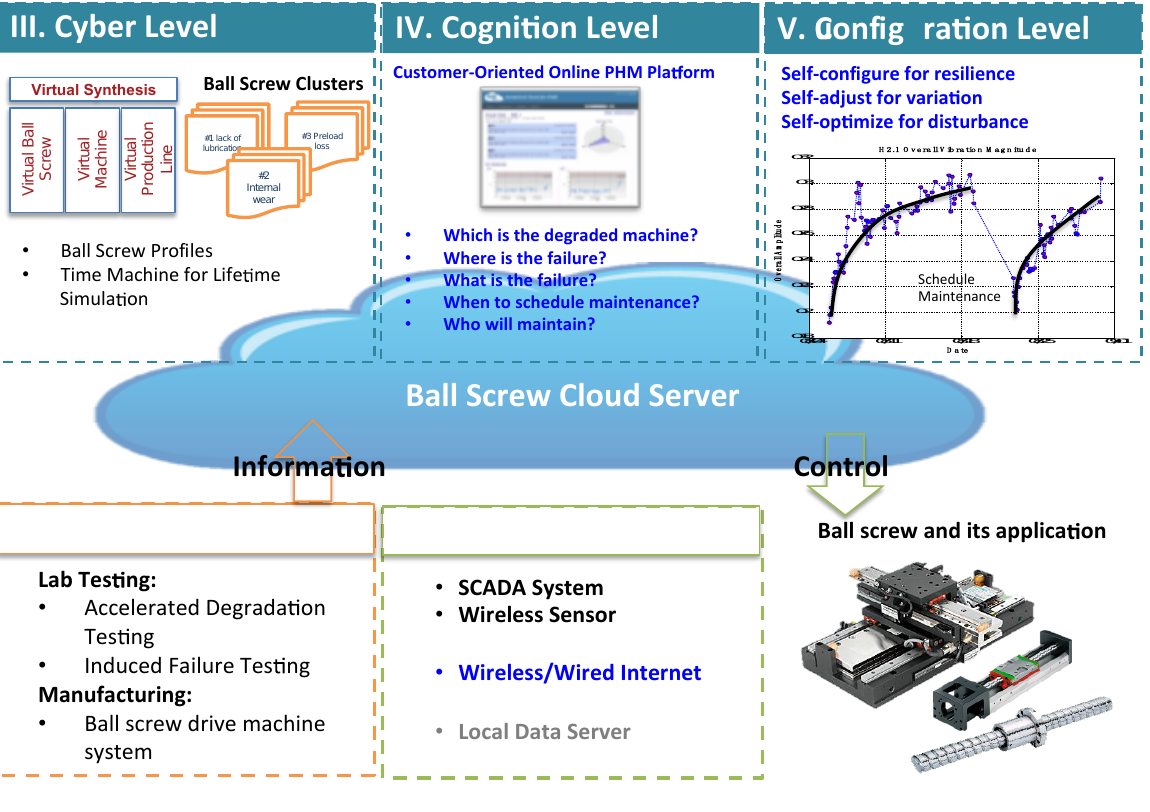
Figure 7. Cyber physical system (CPS) Design for Motion Control